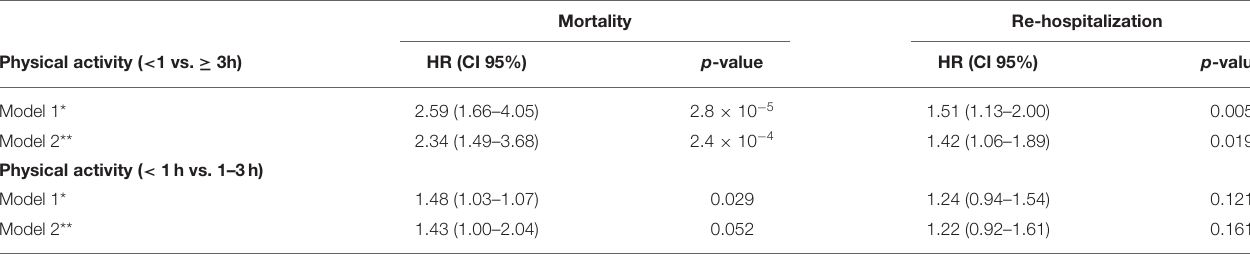
TABLE 3 | Cox regression analysis displaying the association between duration of weekly physical activity and risk of re-hospitalization. Mortality